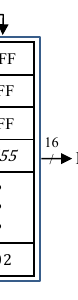
LUT structure. x